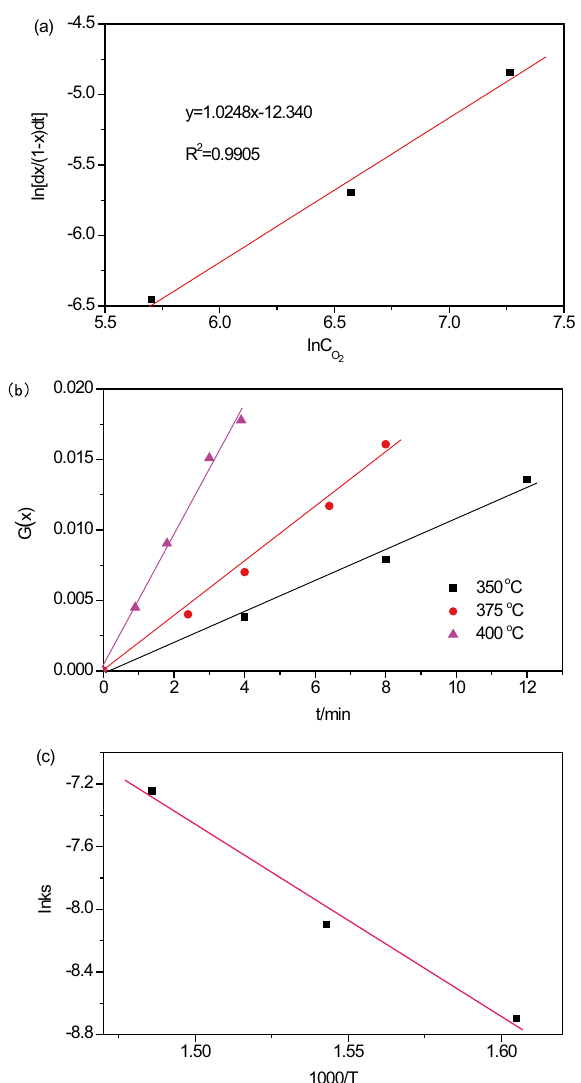
Figure 8. The relationship between the regeneration rate of NiO/sepiolite and O 2 content ( a ), relationship between G(x) and t ( b ), relationship between lnk and 1/T ( c ).